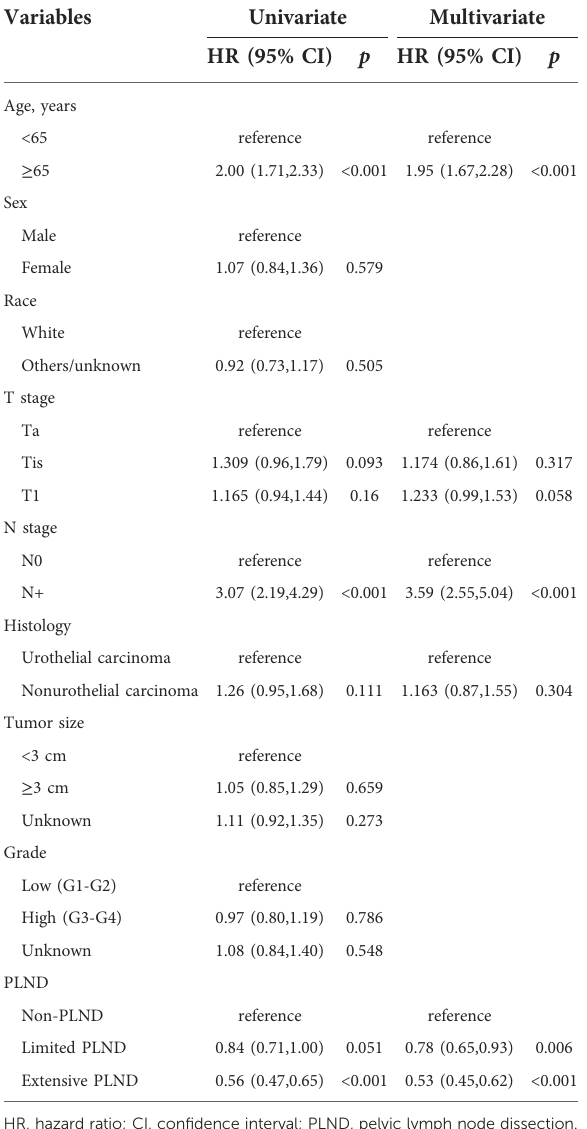
TABLE 2 Univariate and multivariate regression analyses for overall survival in patients diagnosed with NMIBC who underwent